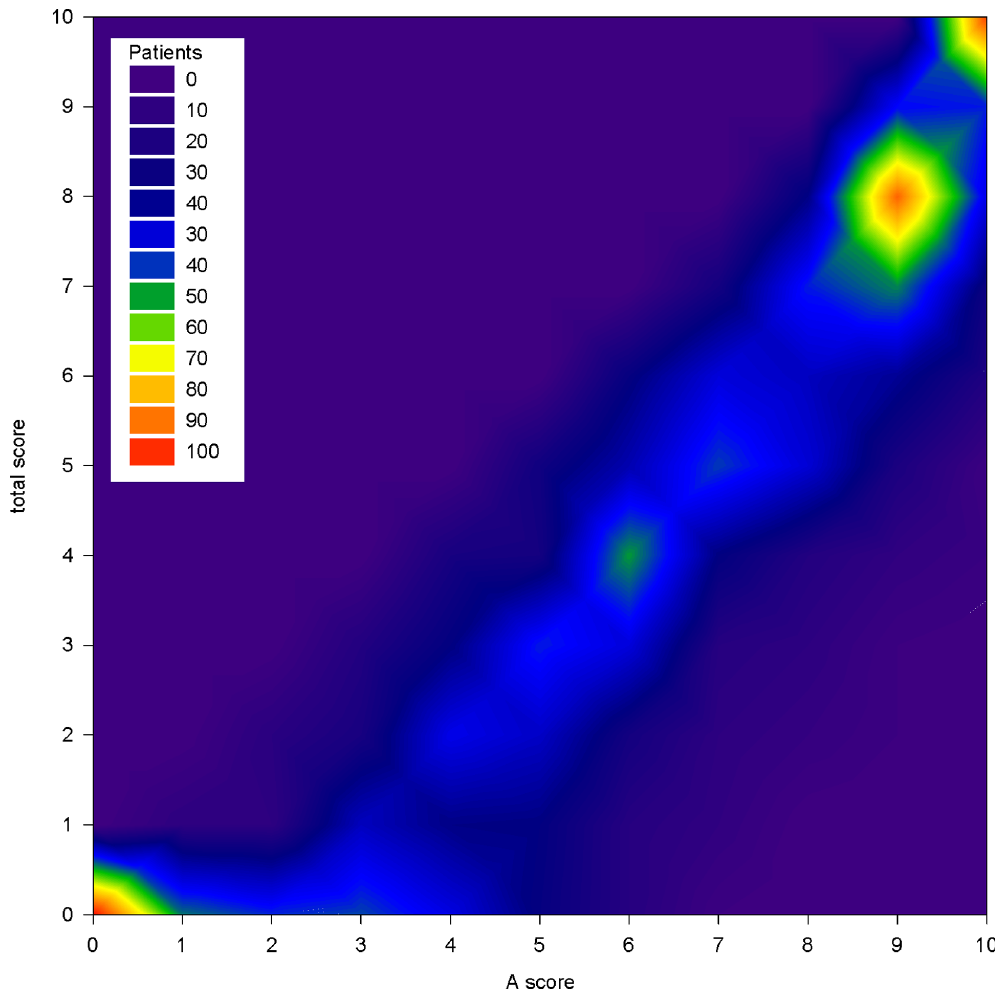
Figure 2. Joint distribution of total and A score in the Consortium on Lithium Genetics sample. Contour plot of the scale scores in 1,308 bipolar disorder patients characterized for response to lithium maintenance treatment.